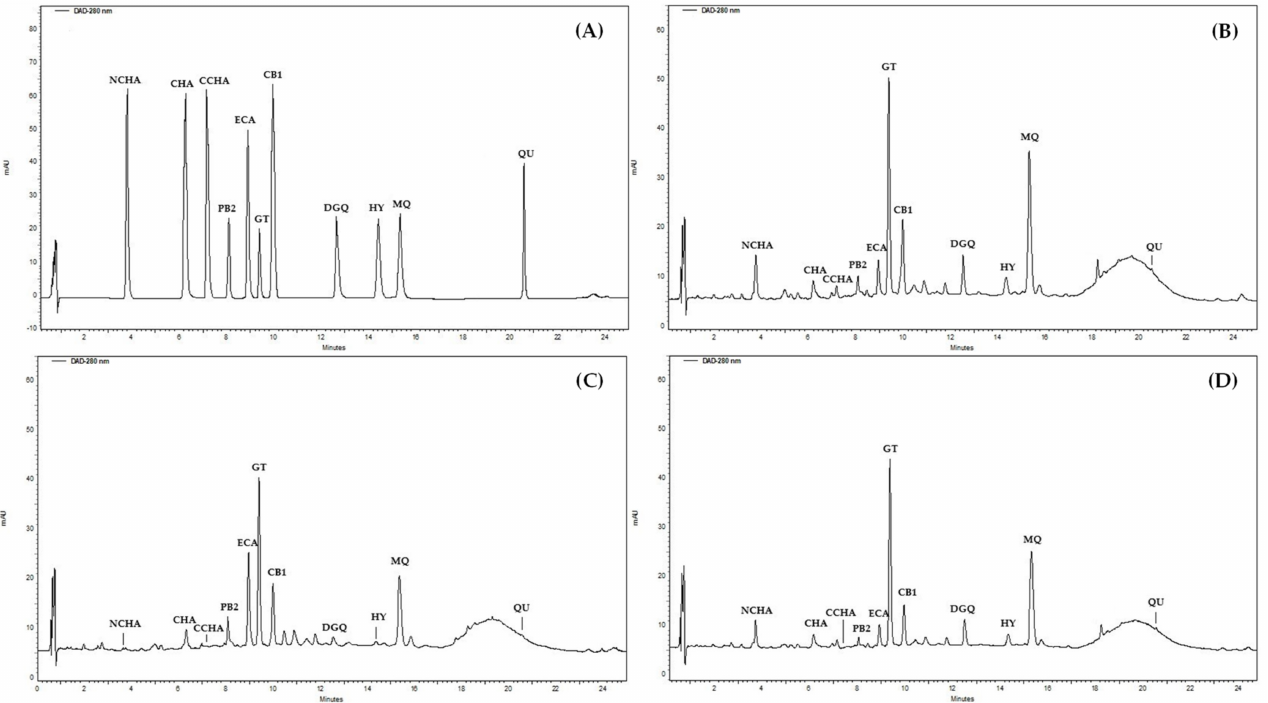
Figure 5. Representative HPLC-PDA chromatograms at 280 nm of: ( A ) standards, and ( B – D ) the methanol-water (75:25, v / v ) extracts (ME) of leaves ( B ), stems ( C ), and the aerial parts ( D ) of G. procumbens separated under optimised conditions. Analytes: QU, quercetin; MQ, miquelianin; HY, hyperoside; DGQ, wintergreenoside A; ECA, ( − )-epicatechin; PB2, procyanidin B2; CB1, cinnamtannin B-1; NCHA, neochlorogenic acid; CHA, chlorogenic acid; CCHA, cryptochlorogenic acid; GT,